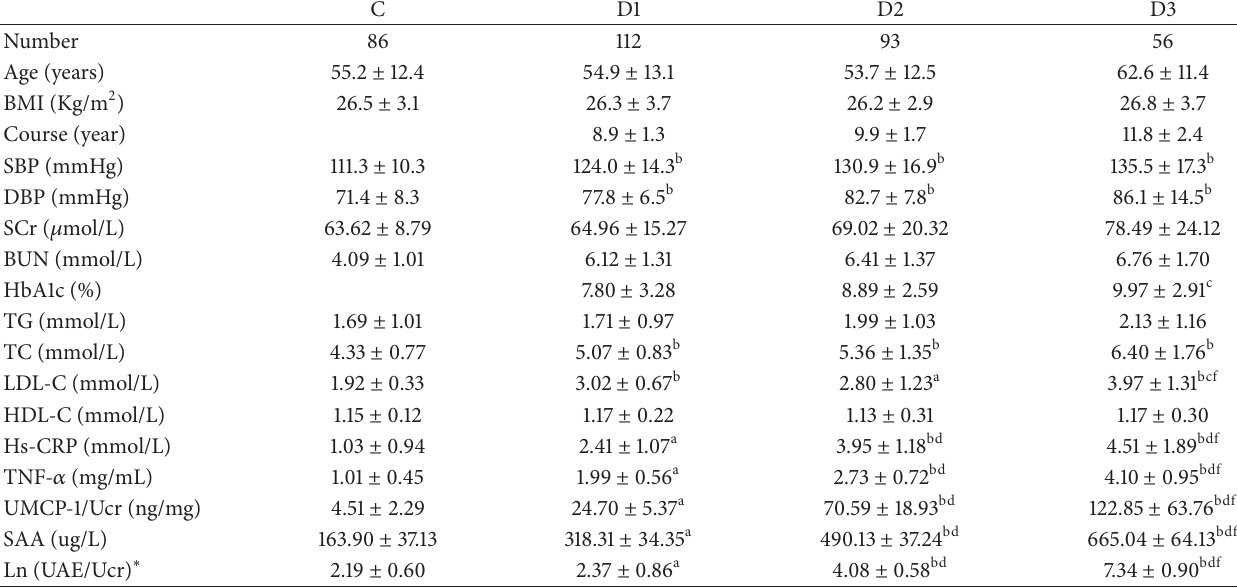
Table 1: Comparison of the general status and study data between diabetes groups and control group.